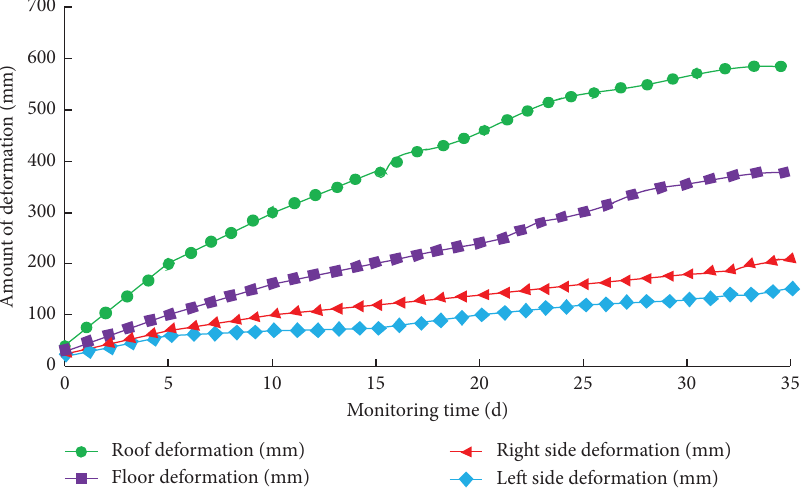
Figure 1: Monitoring curve of roadway surface displacement.